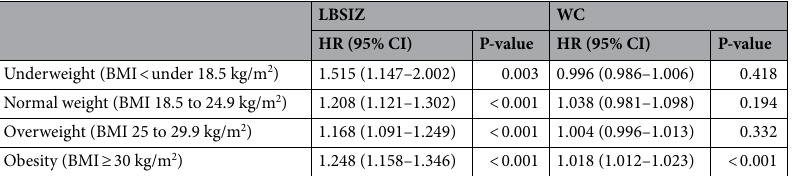
Table 5. Subgroup analysis of the association between each obesity parameter and all-cause mortality according to BMI classification. Adjusted for age, sex, ethnicity/race, smoking status, alcohol consumption, history of cancer at baseline, diabetes mellitus, hypertension, dyslipidemia, and previous cardiovascular disease event. BMI body mass index, WC waist circumference, LBSIZ z-score of the log-transformed A Body Shape